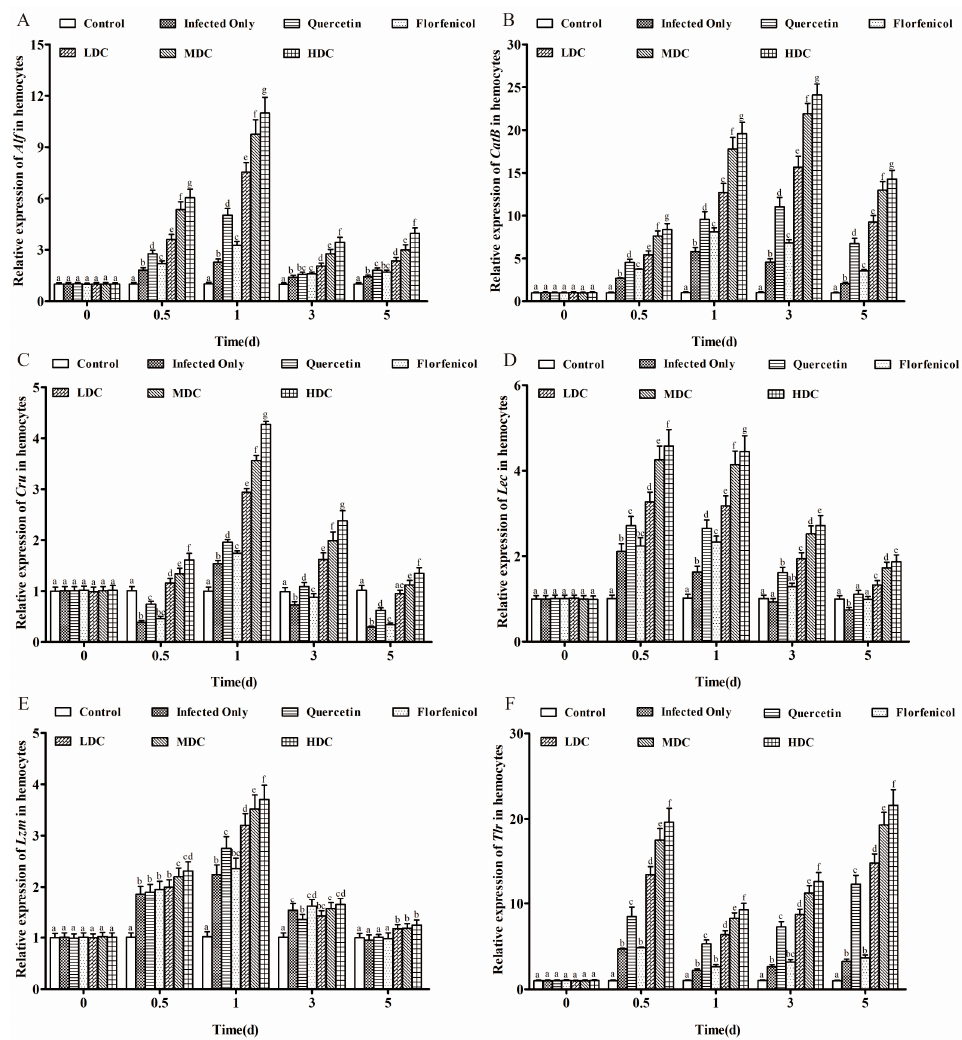
Figure 5. Immunity-related factors’ gene expression in drug-treated L. vannamei. ( A ) Alf , ( B ) CatB , ( C ) Cru , ( D ) Lec , ( E ) Lzm , and ( F ) Tlr in L. vannamei hemocytes at different times after drug treatment. One-way ANOVA and Duncan’s multiple range test were used to analyze the significant differences among different groups, and different letters represent significant differences between groups ( p < 0.05).